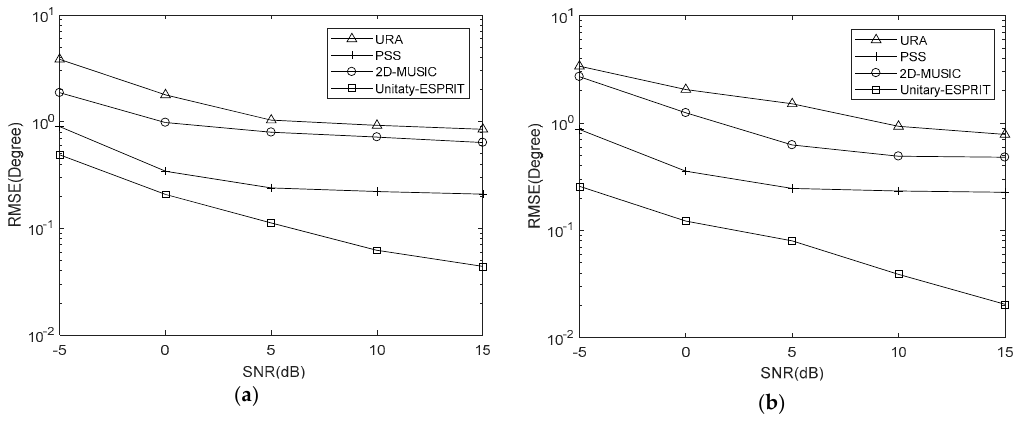
Figure 7. RMSE comparison under different SNRs with K = 7, ∆ θ = ∆ ϕ = 0.5 ◦ ( a ) azimuth ( b ) elevation.